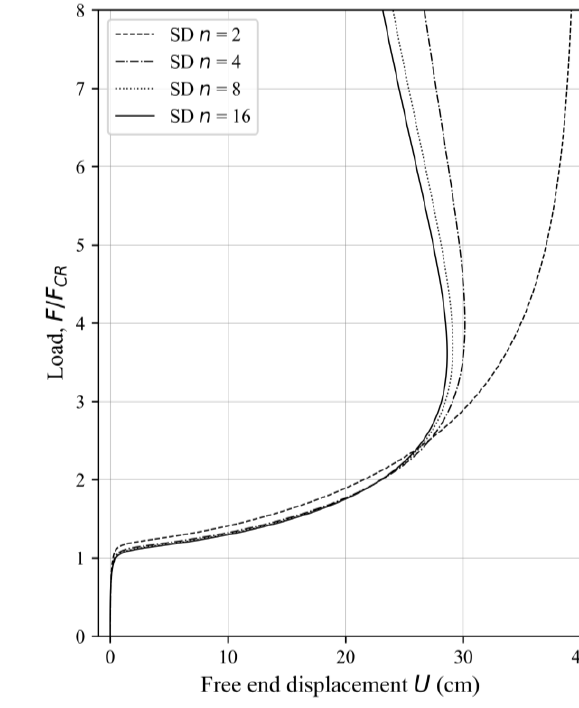
Figure 8. Buckling load convergence vs. free end displacement in the X -direction: ( a ) + F and ( b ) − F .